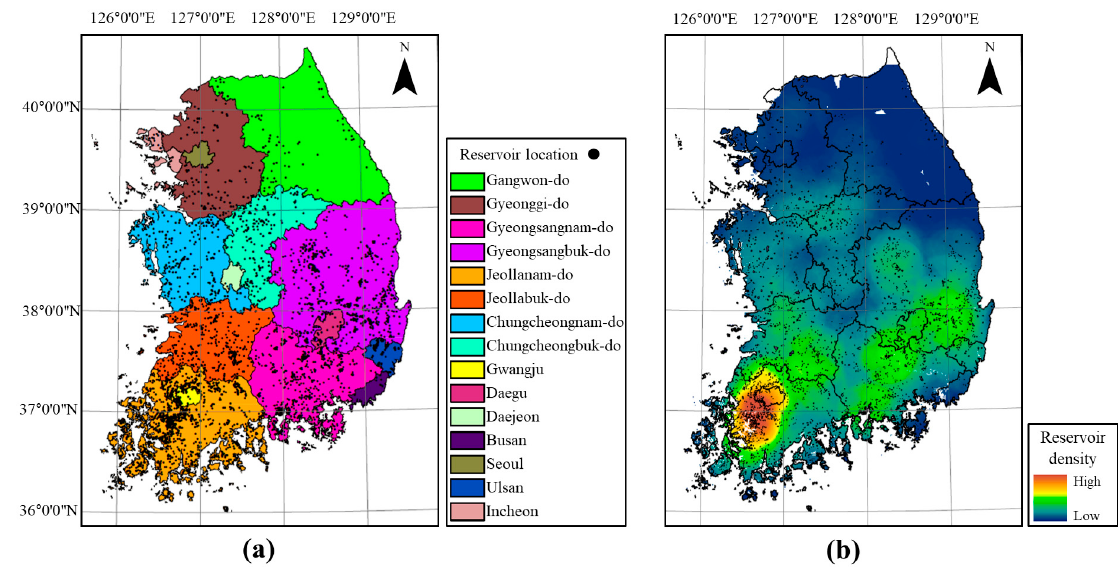
Figure 1. Reservoirs in Korea: ( a ) reservoir locations, provinces and some major cities; ( b ) reservoir density across the country.